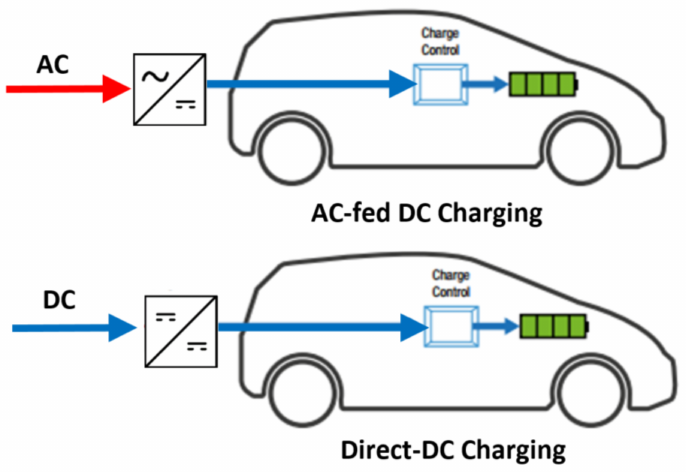
Figure 6. AC-fed versus direct-DC EV